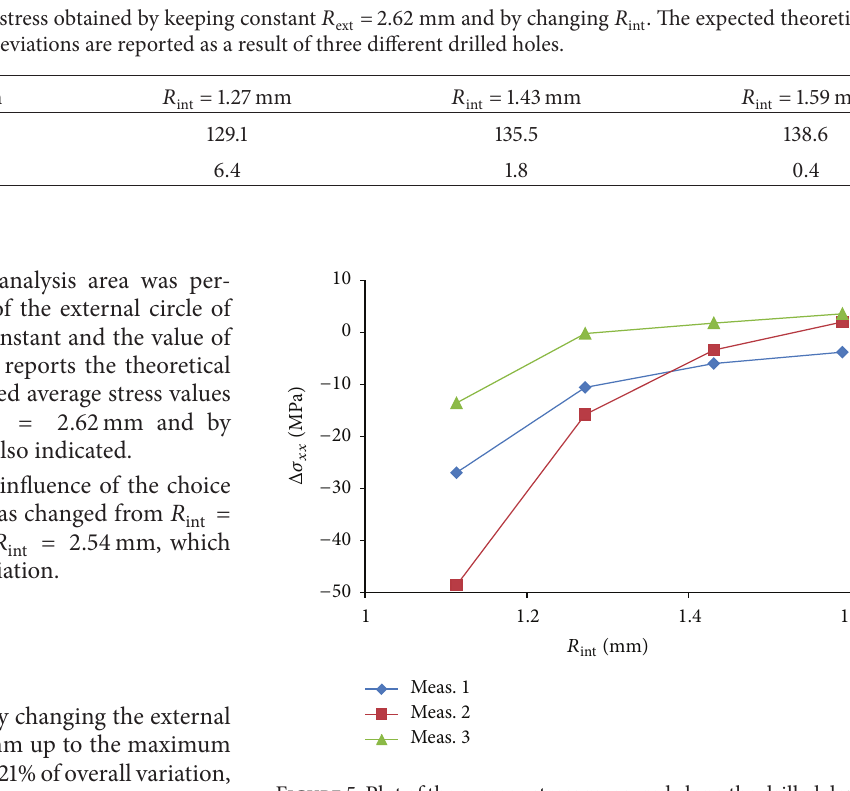
= 2.62 mm and by changing 𝑅 int . The expected theoretical ext